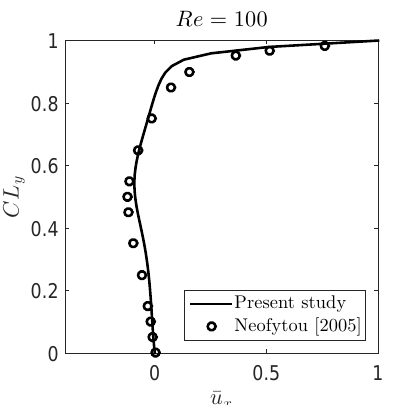
Figure 6. Normalised velocity profiles u at CL y from the present study and its comparison to the work done by Neofytou [48].